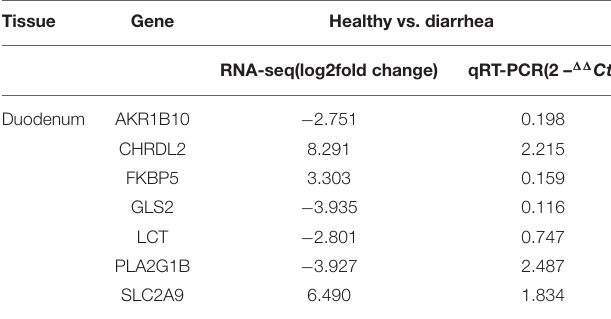
TABLE 1 | Validation of selected RNA-seq-based gene expression data by